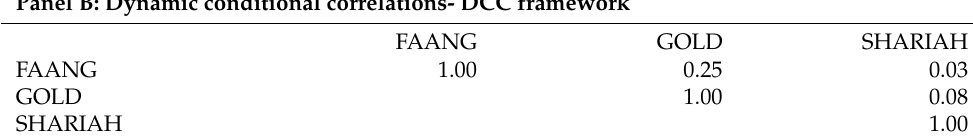
FAANG GOLD FAANG